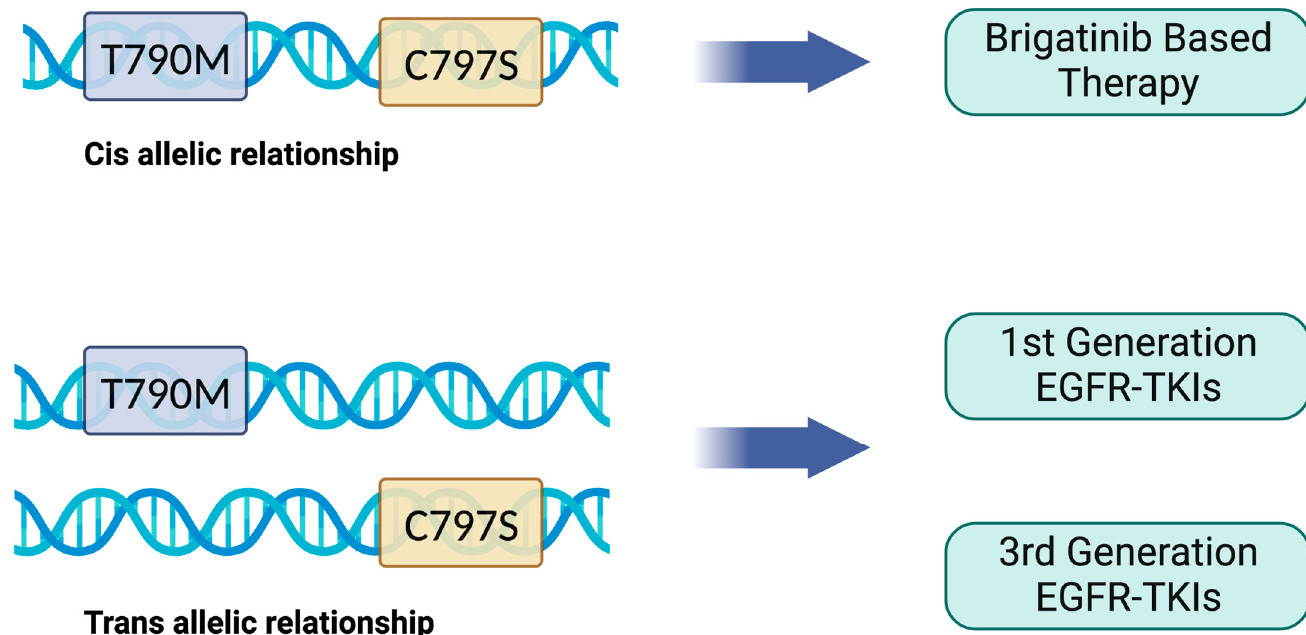
Figure 3. Illustration of the Cis C797S and Trans C797S mutation and their management.